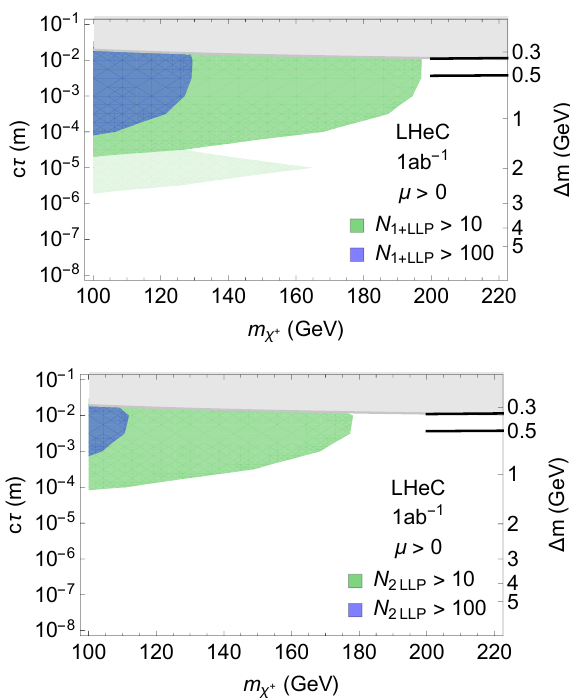
Figure 7 . Regions in the ( m (cid:31) (cid:6) ; c(cid:28) ) Higgsino parameter plane where more than 10 or 100 events with at least one (top) or two (bottom) LLPs are observed at the LHeC. Light shading indicates the uncertainty in the predicted number of events due to di(cid:11)erent hadronization and LLP reconstruction assumptions. Approximately 10 signal events should be discernable against the (cid:28) -background at 2 (cid:27) , in particular for 2 LLPs, so the green shaded region represents an estimate of the exclusion sensitivity. For comparison, the black curves are the optimistic and pessimistic projected bounds from HL-LHC disappearing track searches, see (cid:12)gure